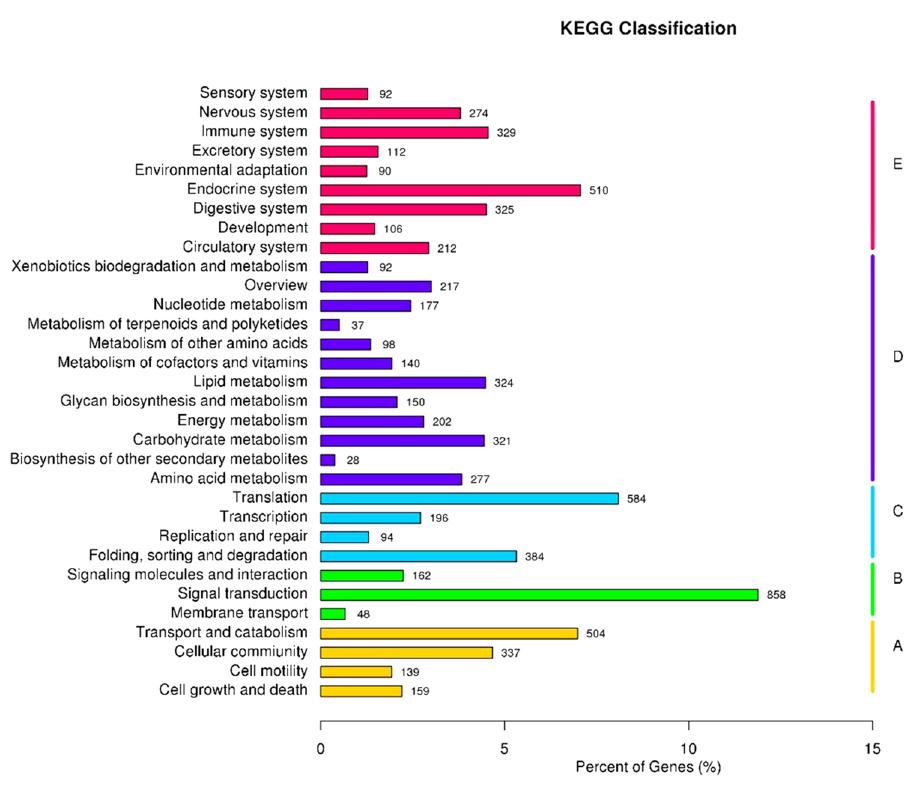
Figure 3. Mapping the KEGG pathway of Ostrinia furnacalis . (A) Cellular processes; (B) environmental information processing; (C) genetic information processing; (D) metabolism; ( E ) organismal systems. KEGG Kyoto Encyclopedia of Genes and